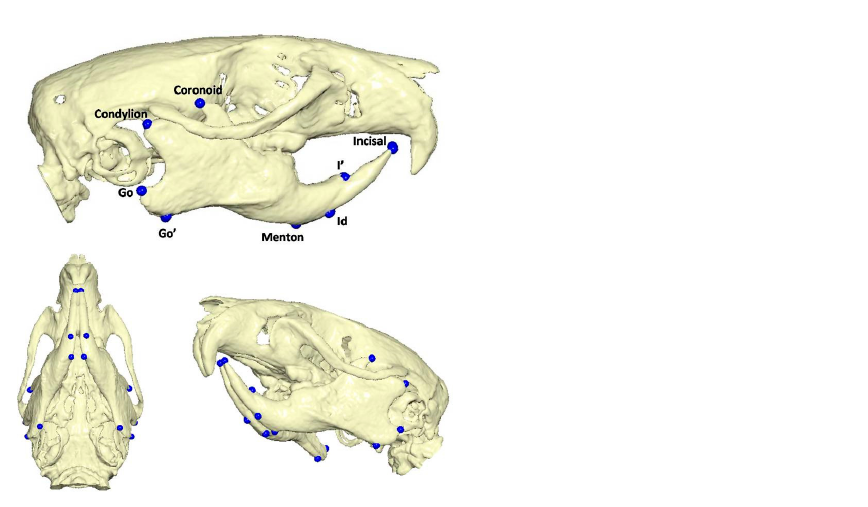
Figure 2. Anatomic landmarks detected in Cone Beam CT reconstructed images.